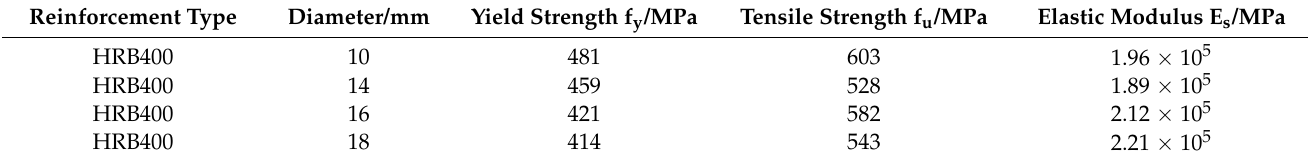
Table 3. Tested parameters of the reinforcement bar.